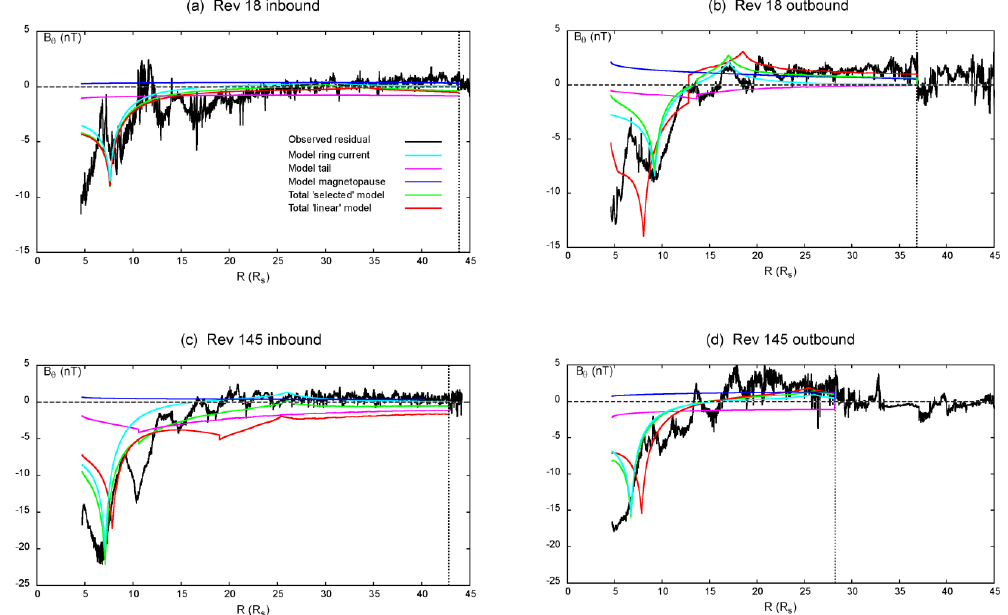
Figure 3. Plots showing the residual co-latitudinal field B θ versus radial distance R ( R S ) together with paraboloid model results for (a) Rev 18 inbound, (b) Rev 18 outbound, (c) Rev 145 inbound, and (d) Rev 145 outbound. The data in each panel are shown in black, while coloured lines show model profiles for the “selected” parameters on each pass as given in Table 3, namely the field due to the ring current (light blue), the tail current (magenta), and the magnetopause current (dark blue), together with the total residual field given by the sum of these components (green). The red line similarly shows the total residual field corresponding to the linear approximation parameters appropriate to the estimated subsolar magnetopause radial distances for each pass (Eq. 4), also given in Table 3. The black vertical dotted line shows the magnetopause limit of applicability of the